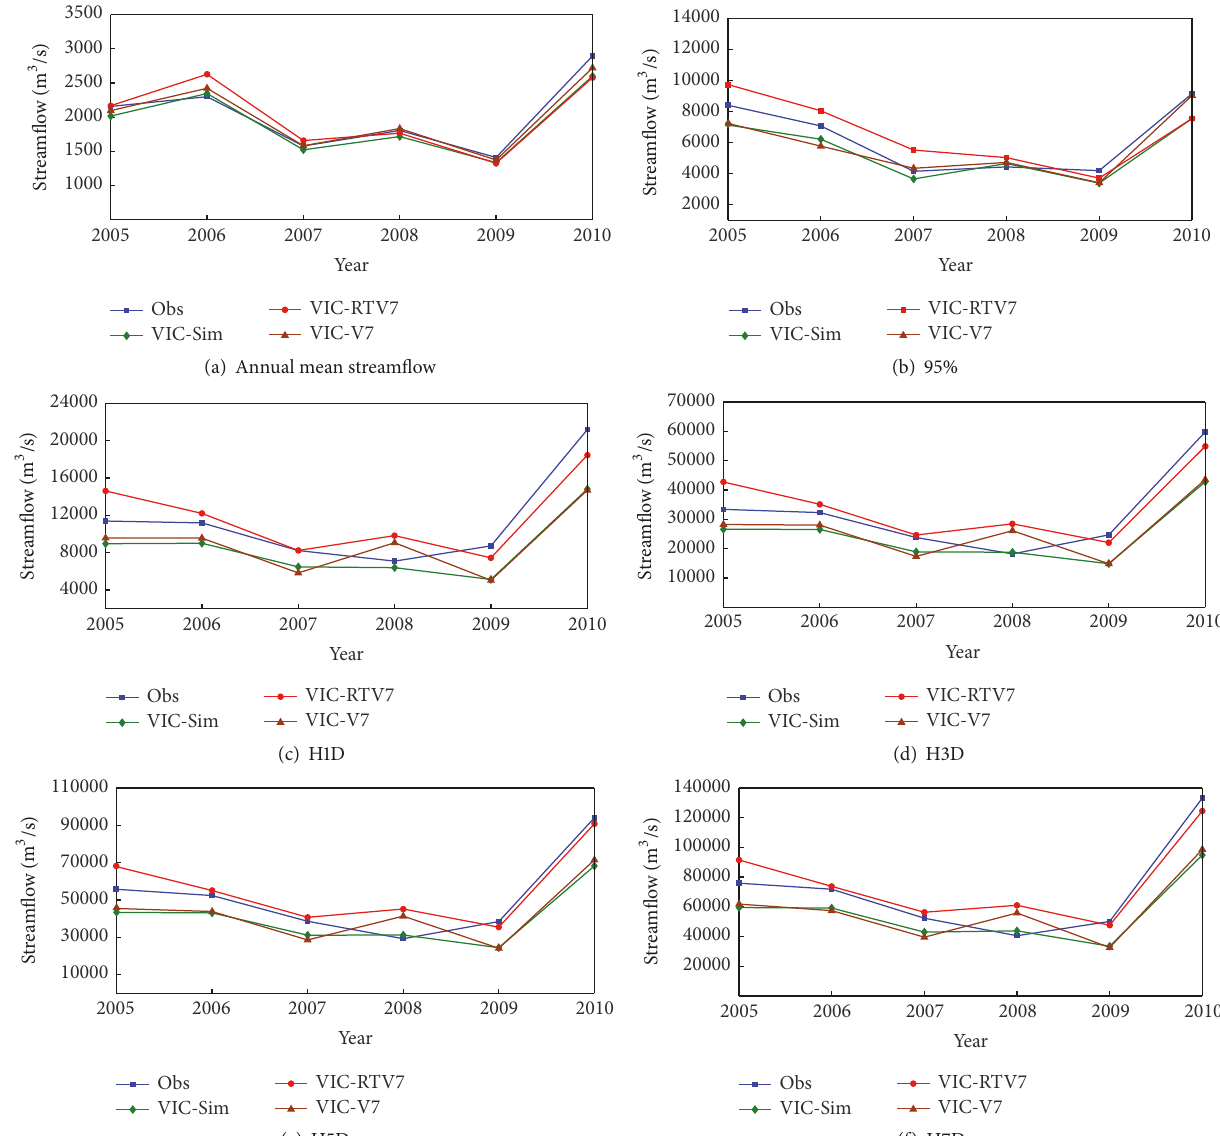
Figure 7: The annual mean streamflow, the extreme value of streamflow of RTV7 and V7, and observed value and simulated value by VIC model in the Ganjiang River Basin from 2003 to